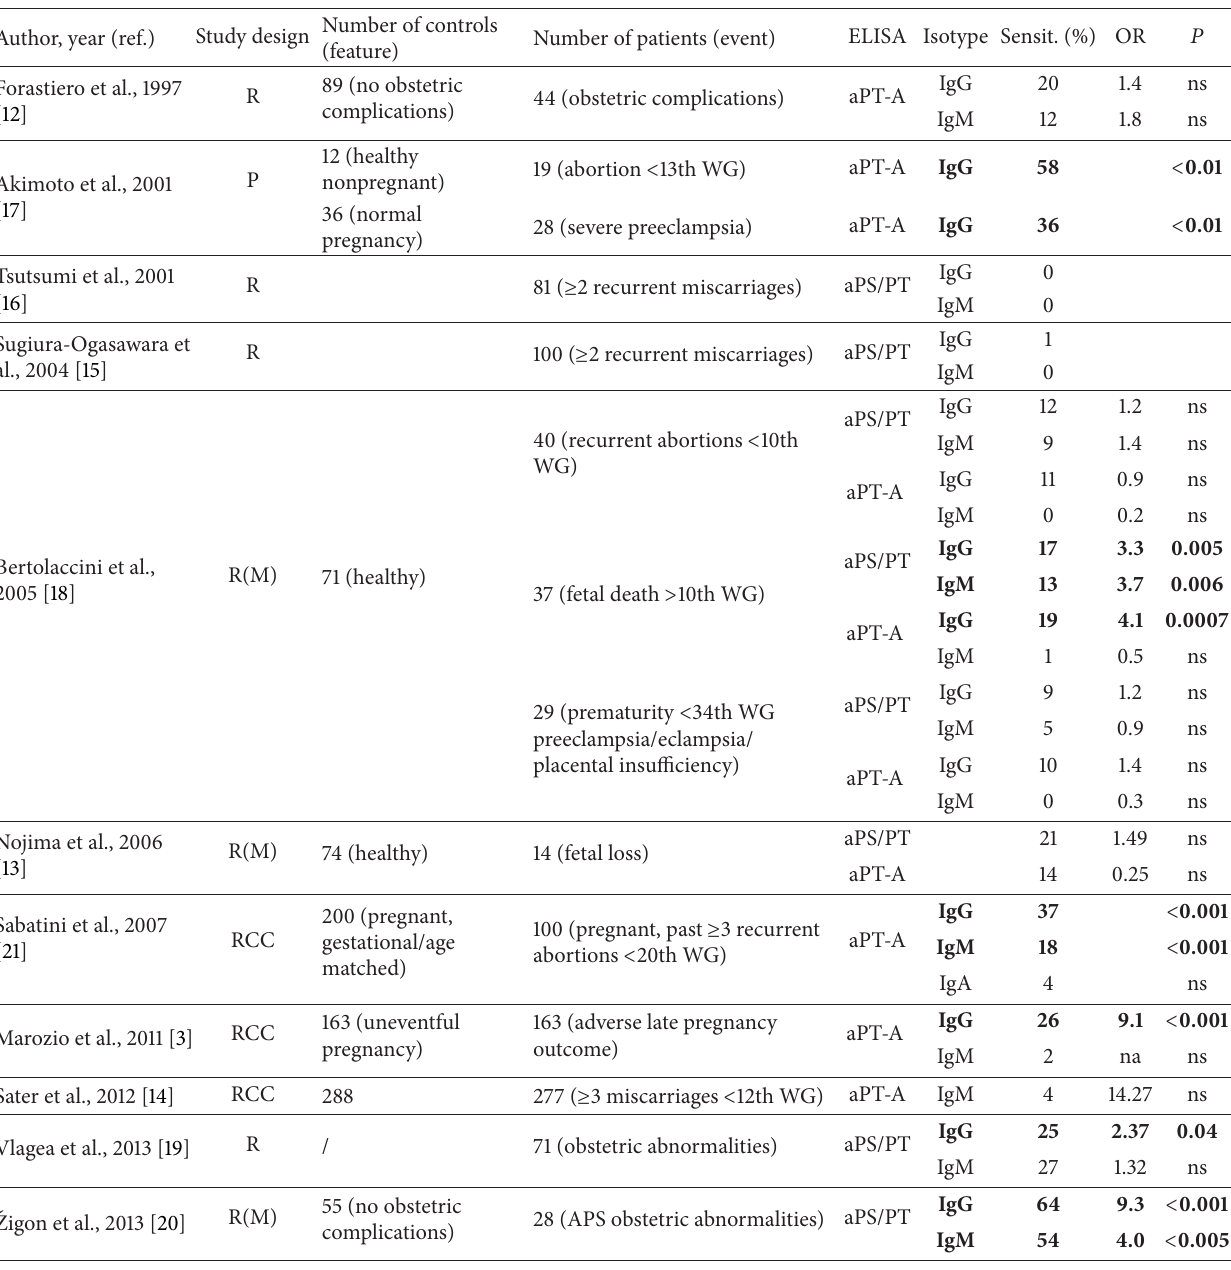
Table 1: Review of antiprothrombin antibodies and pregnancy